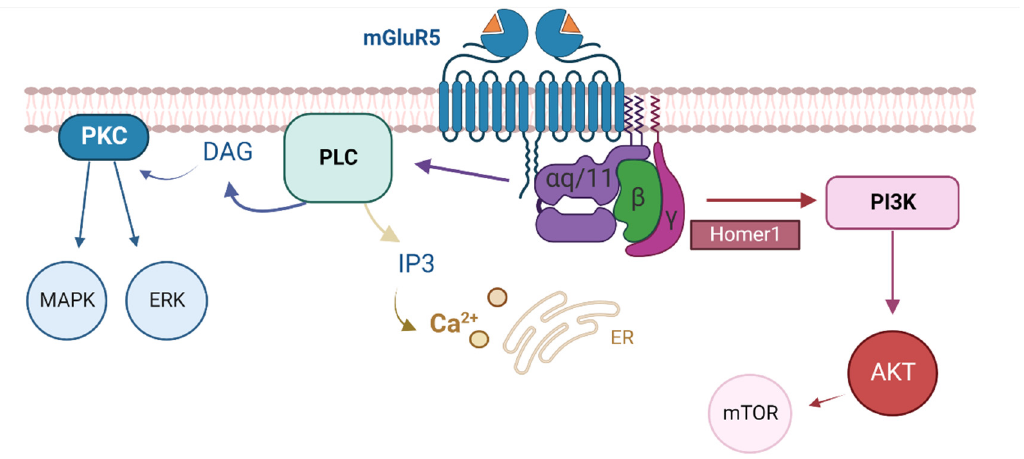
Figure 9. Graphic illustrating the intracellular signalling pathways downstream of mGlu5 receptor activation. mGlu5 receptor-G α q/11 coupling stimulates phospholipase C (PLC) to generate inositol- 1,4,5-triphosphate (IP3), resulting in intracellular calcium mobilisation. Activated PLC also produces DAG, which phosphorylates PKC, MAPK, and ERK and impacts ion channel signalling. mGlu5 receptor stimulation can alternatively stimulate the phosphatidyl-inositol-3kinase (PI3K) pathway, phosphorylating AKT and activating the mammalian target of rapamycin (mTOR). Created with BioRender.com, accessed on 27 May 2022.